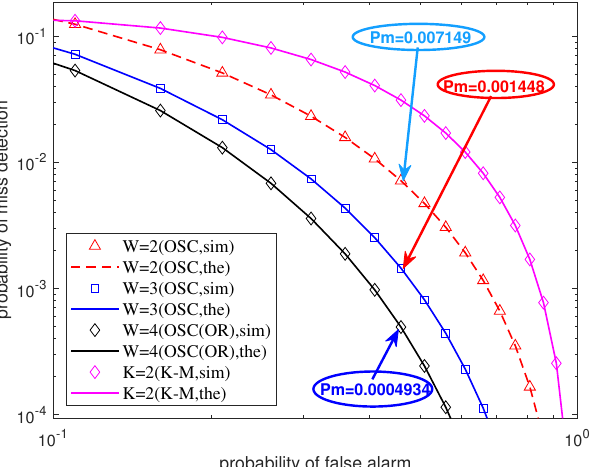
Figure 8. ROC curves for the OSC scheme with different values of threshold ( W = 2, 3, 4) and the K-rank scheme ( K = 2).